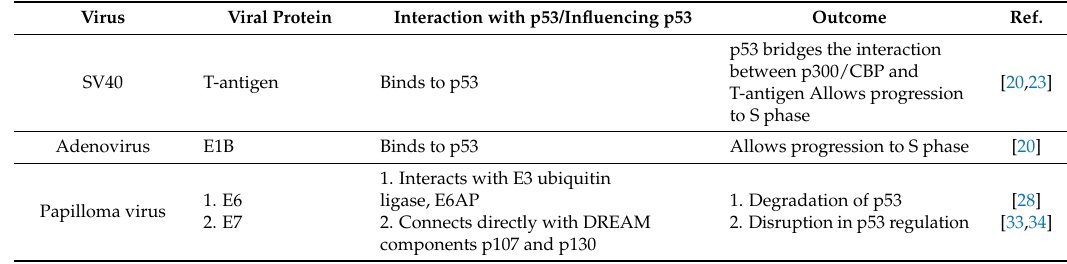
Figure 1. Various viral strategies to manipulate p53-depndent host defense. Table 1. Various viral proteins and their interactions with p53. Interaction with p53/Influencing p53 Outcome